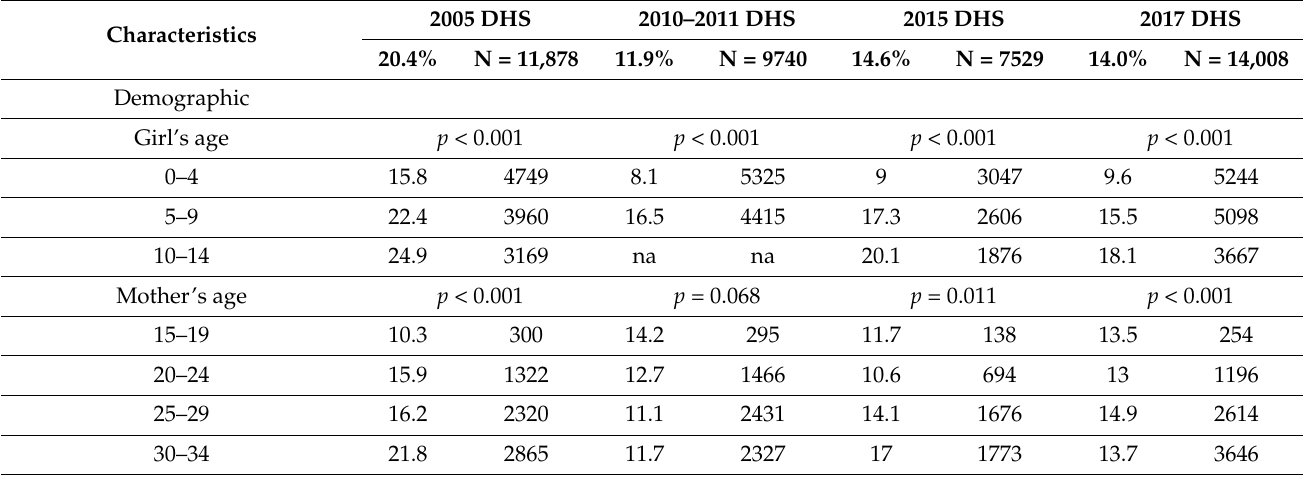
Table A1. Trends in the FGM/C prevalence among Senegalese girls aged 0–14 years by main characteristics, SDHS 2005–2017. Characteristics